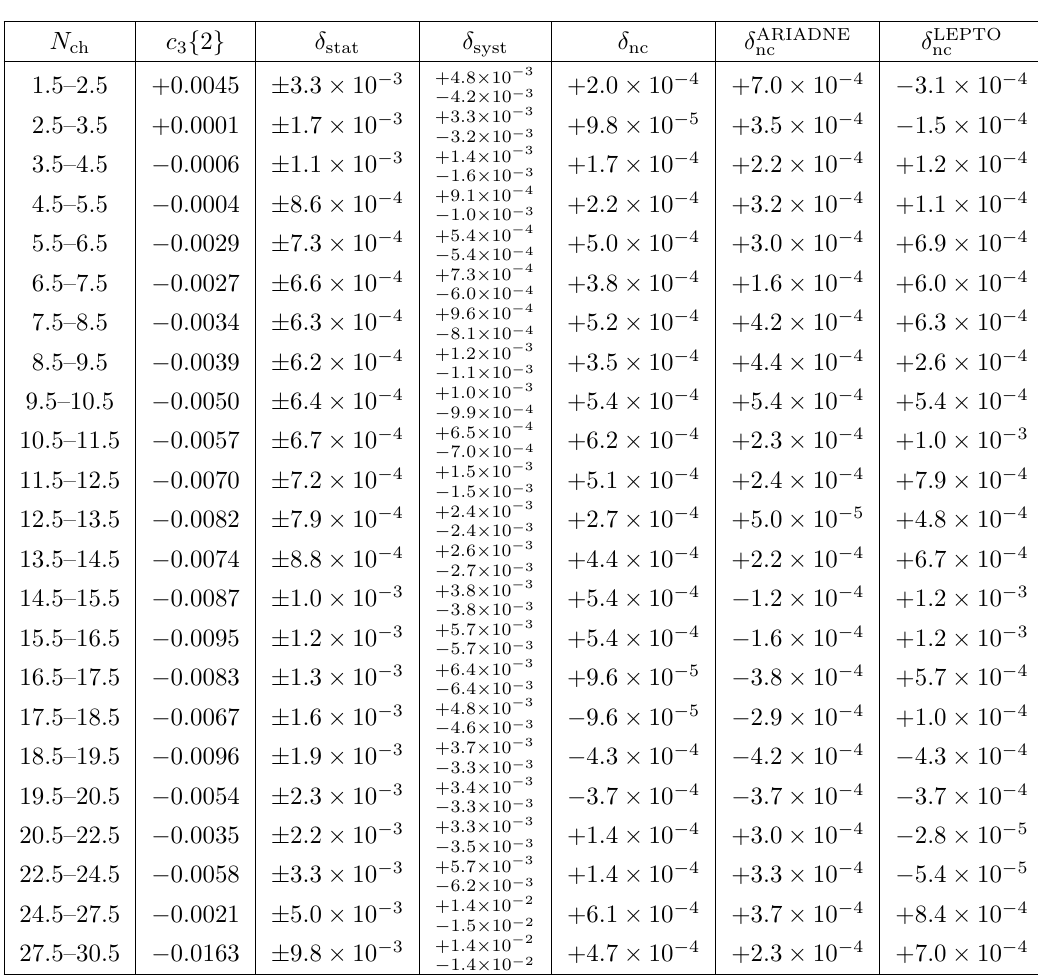
Table 9 . c 3 f 2 g versus N ch from (cid:12)gure 7 (c), p T > 0 : 5 GeV, j (cid:1) (cid:17) j > 2; (cid:14) stat , (cid:14) syst and (cid:14) nc denote the statistical, systematic and Monte Carlo non-closure uncertainties,